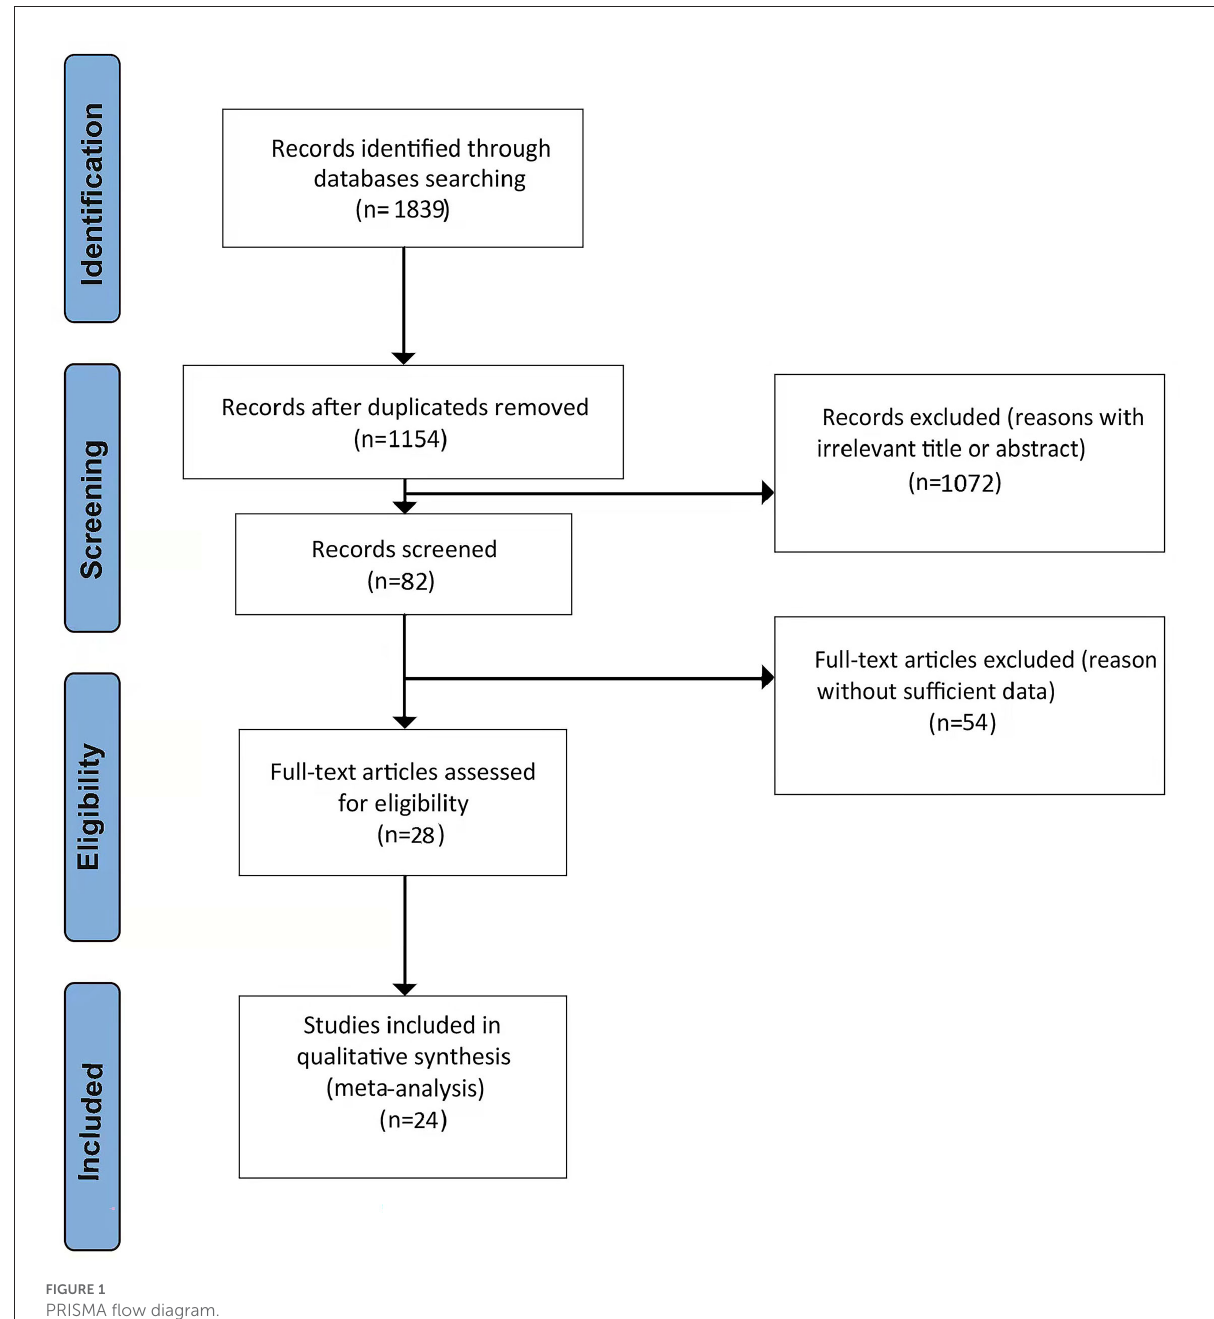
FIGURE1 PRISMA flow